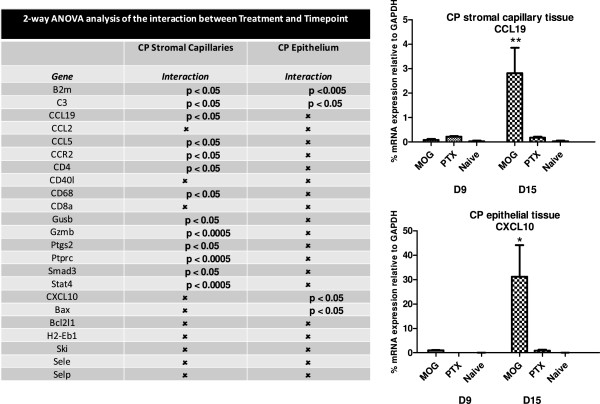
Interaction between immunization treatment and time of analysis post-immunization on expression of immune-related genes within CP stromal capillary and choroidal epithelial compartments. Interactive effects of treatment (MOG-CFA/PTX, CFA-PTX and naïve) and time post-immunization were determined by two-way ANOVA on the 23 immune-related genes that were super-induced following MOG-CFA/PTX immunization in either of the two CP compartments (those genes graphed in Figures 3, 4A and B). Of these 23 genes, 13 genes in the CP stromal capillary and 4 genes in the CP epithelial tissue exhibited significant positive interaction between treatment and time post-immunization, and are denoted with their corresponding p values. The remaining genes that showed no significant interaction are labeled by (x). Time-dependent changes in expression of CCL19 in stromal capillary tissue and CXCL10 in choroidal epithelial tissue are graphed as representative examples * p < 0.05, ** p < 0.005.